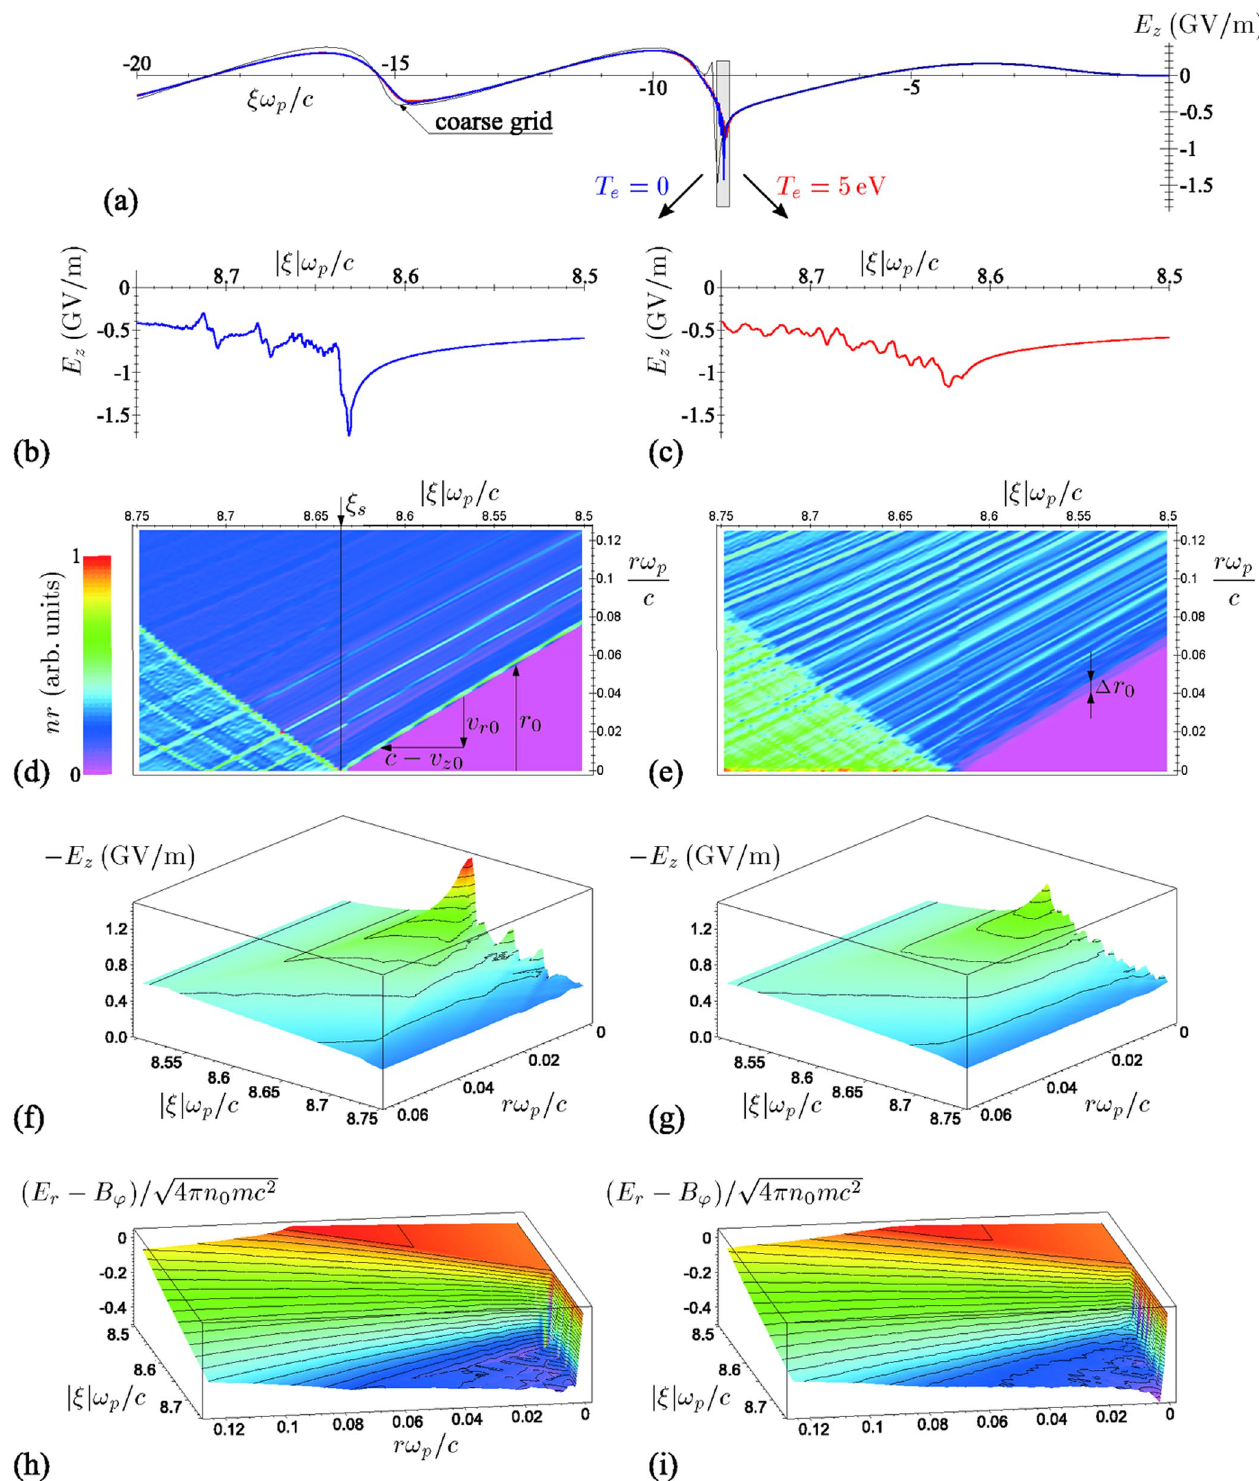
FIG. 5. (Color) Plasma and field behavior in the vicinity of the highest accelerating field: (a) on-axis values of E and the location of the magnification window; (b),(c) on-axis values of E density (multiplied by r for better visibility); (f),(g) longitudinal electric field; and (h),(i) focusing force with zero (b),(d),(f),(h) and nonzero (c),(e),(g),(i) plasma